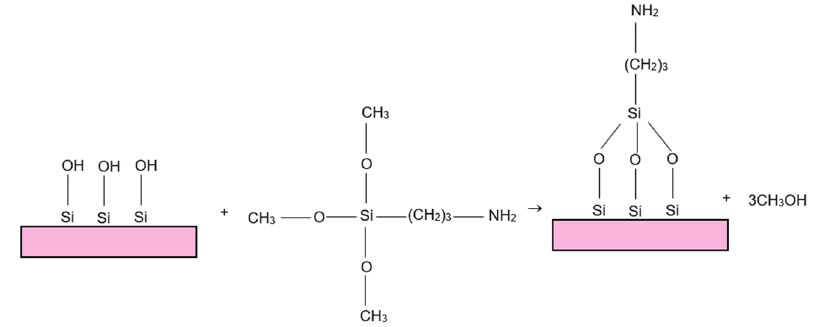
Figure 1. Chemical reaction on the surface of the silica particles.